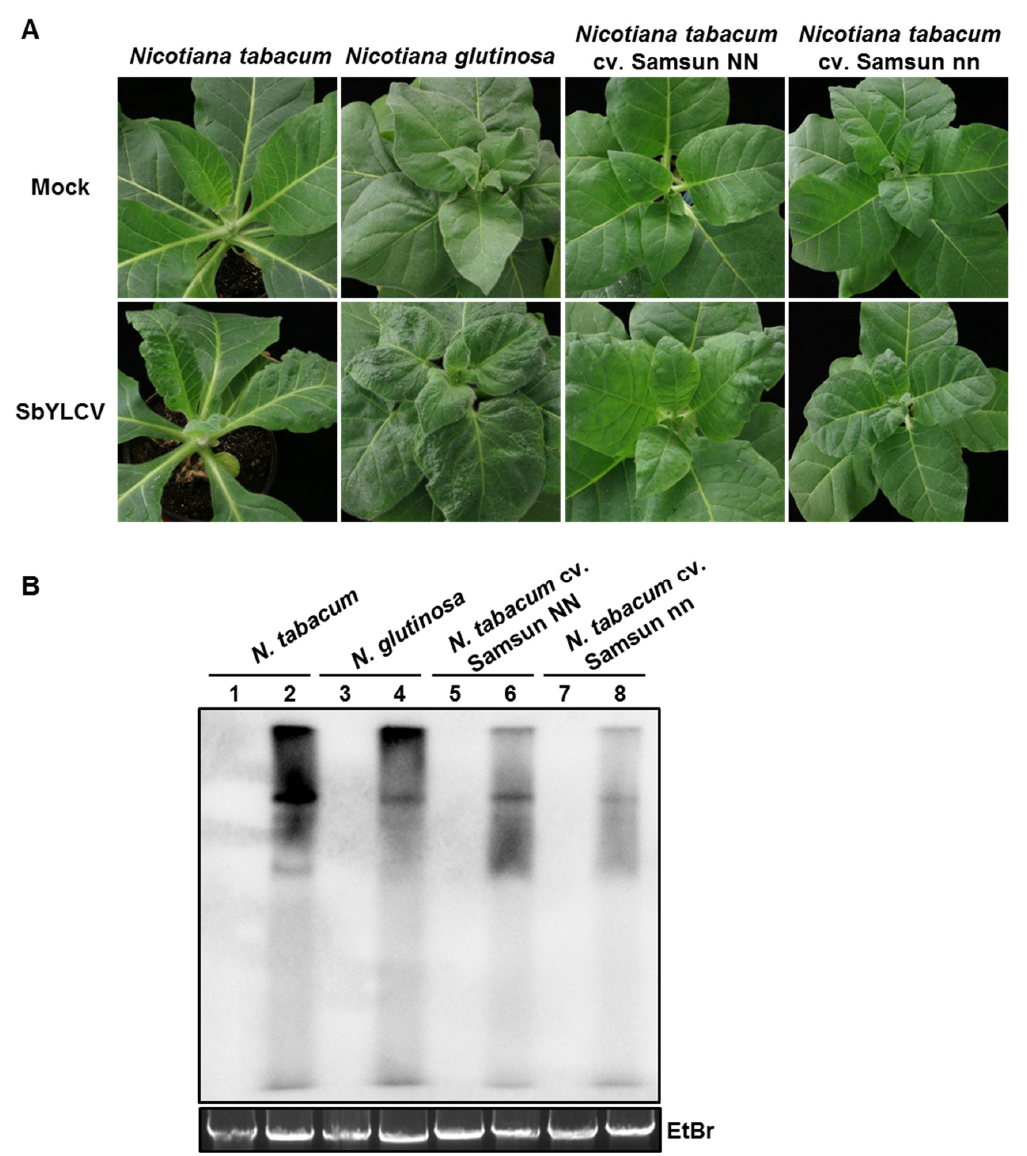
Figure 6. Systemic infection of SbYLCV in Nicotiana tabacum , N. glutinosa , N. tabacum cv. Samsun NN, and N. tabacum cv. Samsun nn plants. ( A ) Characteristic symptoms induced by SbYLCV. Plants were agroinoculated with the pBinPLUS vector (mock) or the infectious clone of SbYLCV, as indicated. Photos were taken at 30 days post-inoculation (dpi). ( B ) Southern blot hybridization analysis of SbYLCV DNA with a specific DIG-labelled DNA probe. Total DNA was extracted from systemic leaves of SbYLCV-infected and mock-inoculated plants, as indicated. Lanes 1, 3, 5, and 7 represent total DNA extracted from plants inoculated with the pBinPLUS vector; lanes 2, 4, 6, and 8 represent total DNA extracted from plants inoculated with the infectious clone of SbYLCV. Ethidium bromide staining of total DNA was used as a loading control.